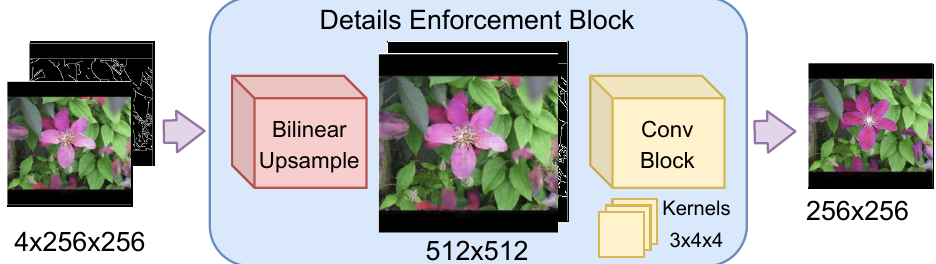
Figure 6. The Detail Enforcement Block design is similar to that of the AGB. The difference resides in the task of the convolutional layer, which retraces the input sketch for fine and sharp